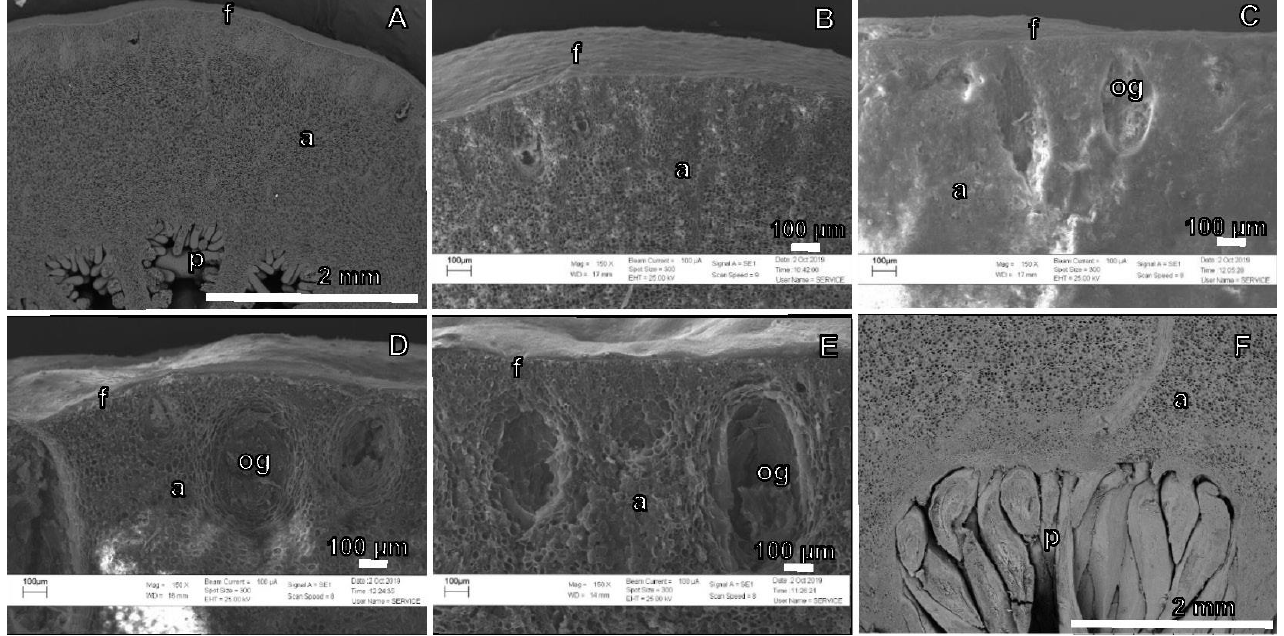
Figure 4. Cross-sections of orange fruits at different developmental stages with a focus on the albedo (a), flavedo (f), oil glands (og) and pulp (p). Micrographs correspond to 30 DAFB ( A , B ), 44 DAFB ( C ), 66 DAFB ( D ), and 99 DAFB ( E , F ).